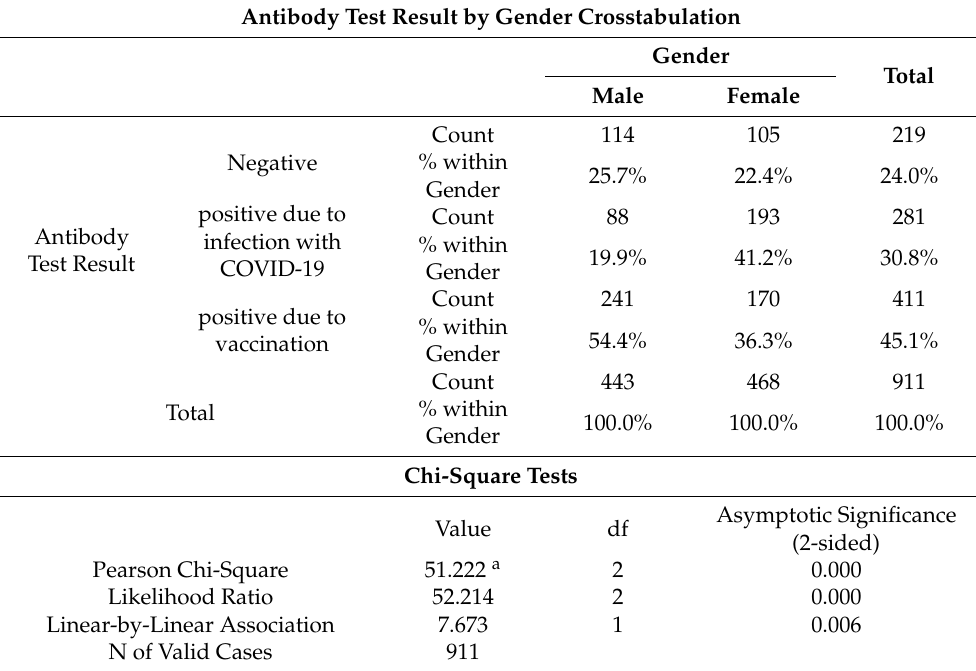
Table 9. Seroprevalence according to gender and source of antibodies (infection or vaccine). Antibody Test Result by Gender